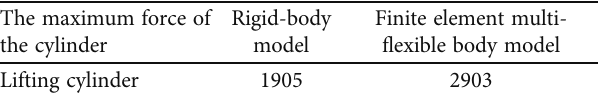
Table 3: Hydraulic cylinder maximum force comparison between the two models (N).